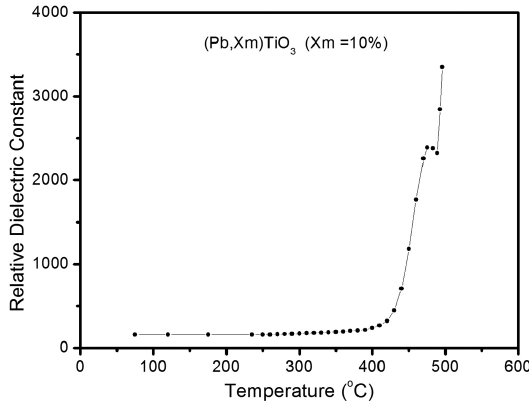
Figure 7. Hysteresis loop measurements performed at room temperature in the PXT15 sample sintered at 1150